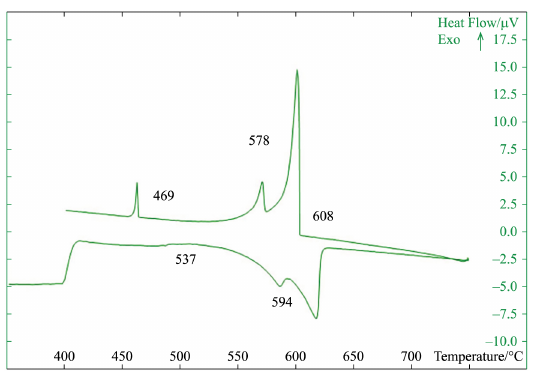
Table 4. Influence of zinc and calcium on hardness (HB) of the alloys Al-3.5%Mg-Zn-Ca in different states 1 .